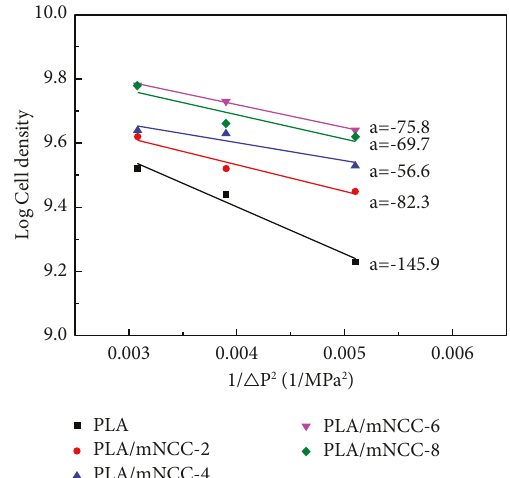
Figure 16: Logarithmic relationship between parameter 1/2 and cell density of pure PLA and